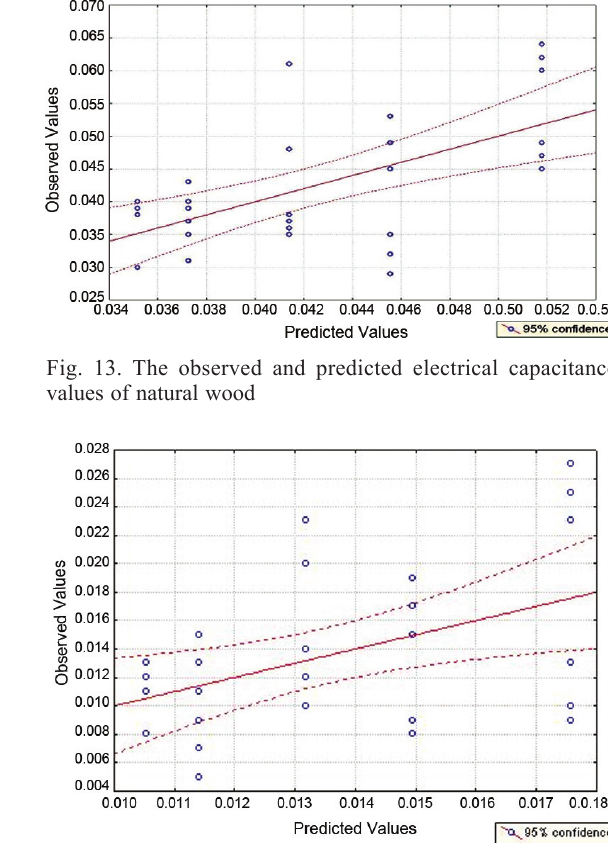
fig. 14. the observed and predicted values of electrical conductivity for natural